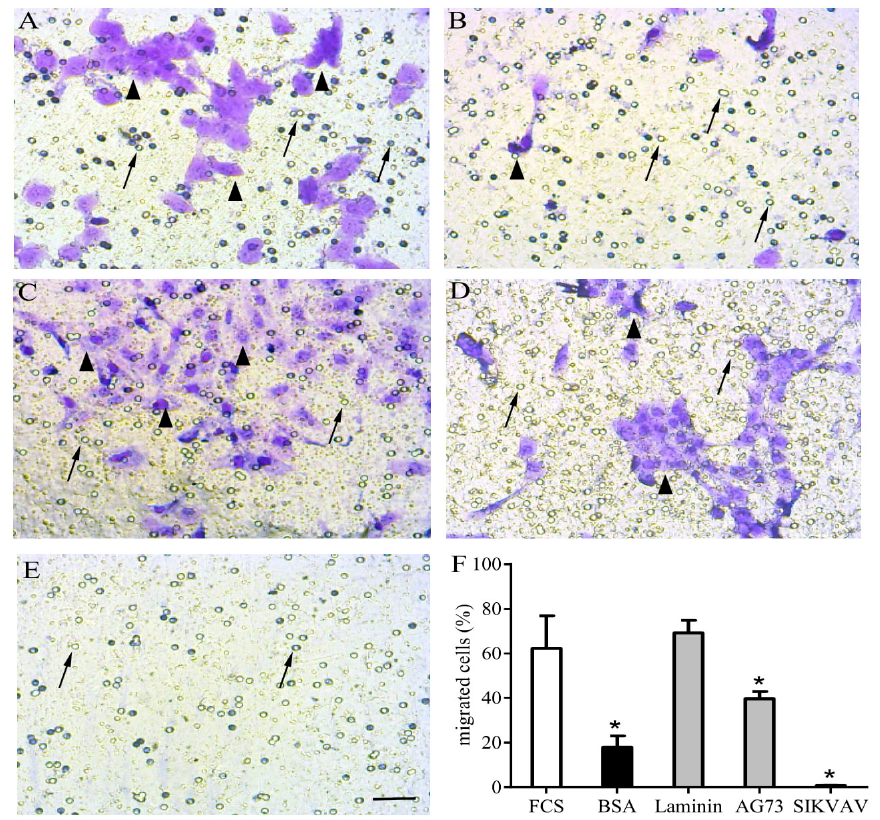
Figure 4. Matricryptins and in vitro myoblast chemotaxis / migration. Laminin-111 and laminin-derived peptides were used to evaluate C2C12 myoblast chemotaxis / migration assayed in a transwell system. The cells were plated over a membrane (8 µ m pores) and fetal calf serum (FCS) 20% was used as a positive migration control in the lower chamber ( A ). All other stimuli were applied in the absence of FCS, with highly purified bovine serum albumin (BSA) as a negative control ( B ), full length laminin-111 ( C ), and the laminin-111-derived peptides AG73 (RKRLQVQLSIRT) ( D ) and SIKVAV ( E ), all at concentrations of 100 µ g / well. After a 12 h incubation, the unresponsive cells were gently removed from the membrane’s upper surface, and the cells that migrated were fixed and stained using crystal violet diluted in ethanol. The graphic shows the relative number of cells that migrated towards the lower chamber according to the indicated stimulus ( F ). The myoblasts are indicated by arrowheads, and arrows indicate membrane pores. * means p < 0.05. Bar: 40 µm.